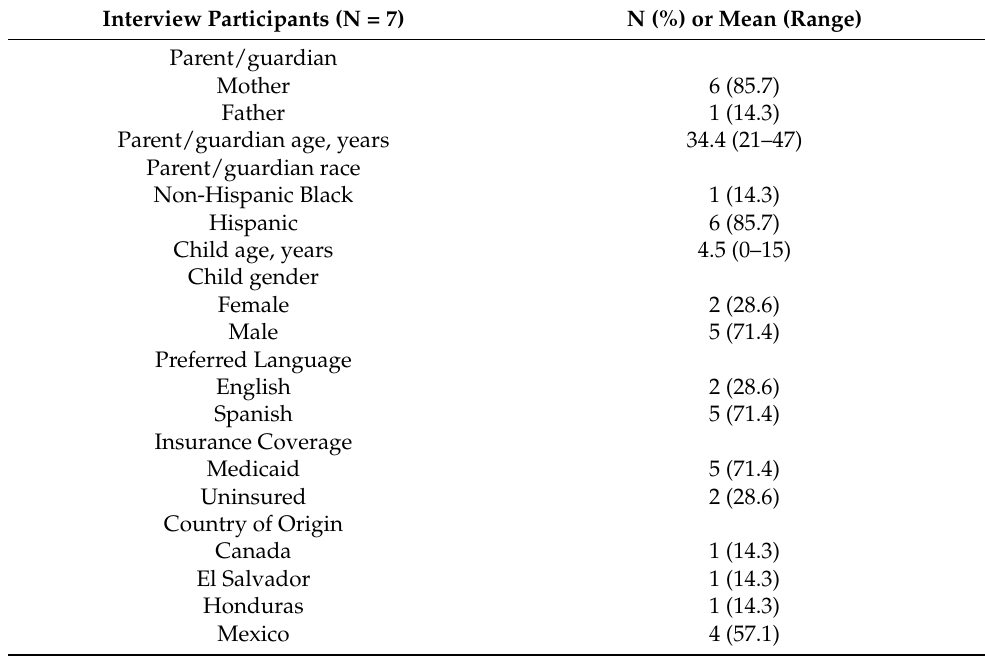
Table 2. Interview Participants’ Characteristics.